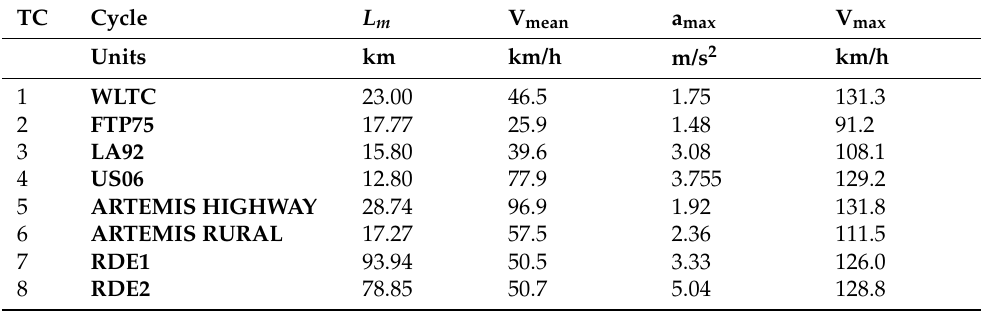
0 and s 0 and their fitting